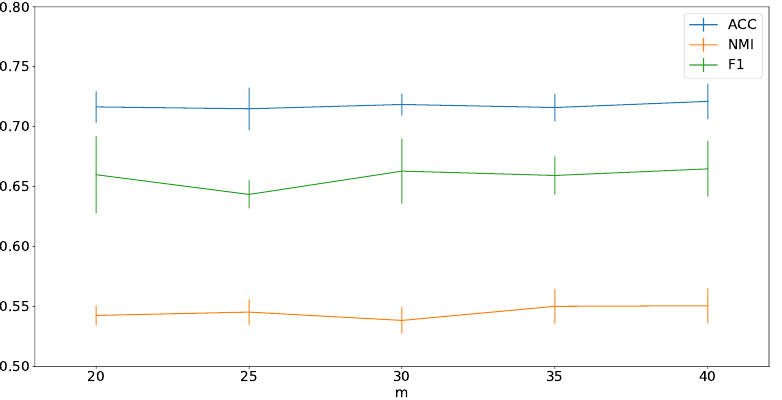
Figure 4. The influence of m on the results of the Cora dataset in GLGC. The error bar denotes the standard deviation of 10